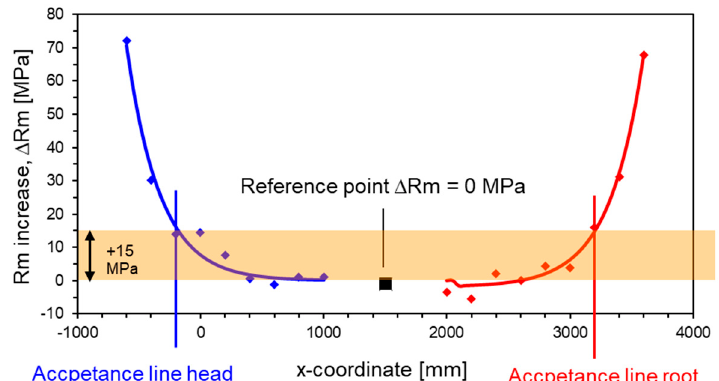
Figure 17. Measuring procedure for determining the cold ends at the plate head and at the plate root.